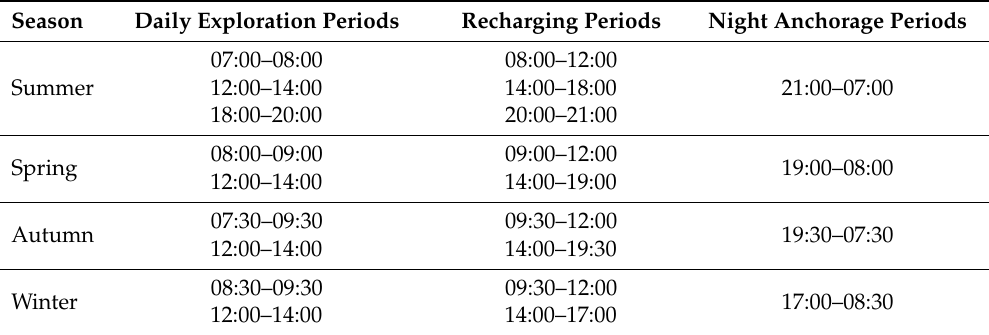
Table 4. Box exploration time bands, stoppages and recharging periods in different seasons of the